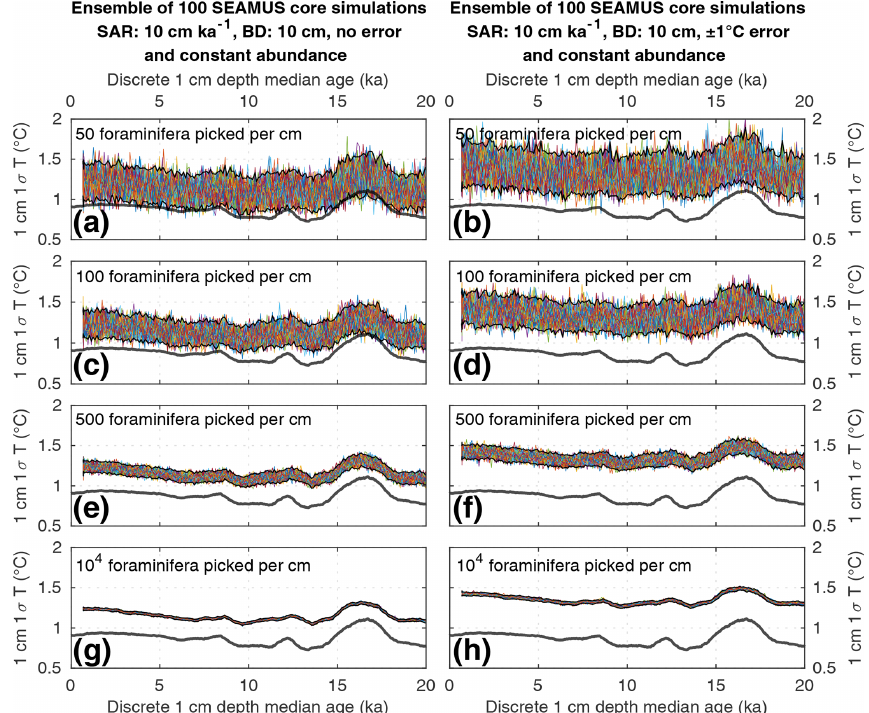
Figure 3. Simulated downcore, discrete 1cm depth 1 σ SST values of simulated single foraminifera from various 10cmkyr − 1 SAR scenarios with 10cm BD, each with 100 ensembles of SEAMUS runs. In each panel, each ensemble is shown using a coloured line. The solid black lines represent the 95% interval of the ensemble runs at each discrete 1cm depth. Also shown for reference as a thick grey line is the 1000 year (12000 month) moving 1 σ of the 1.5–7 year filtered monthly SST data (as also shown in Fig. 1c). The left panels (a, c, e, g) show the output of scenarios with 50, 100, 500 and 10 4 randomly picked foraminifera per discrete 1cm depth, all with constant species abundance and no assumed analytical error. The right panels (b, d, f, h) show the output of scenarios with 50, 100, 500 and 10 4 randomly picked foraminifera per discrete 1cm depth, all with constant species abundance and an assumed analytical error of ± 1 ◦ C in